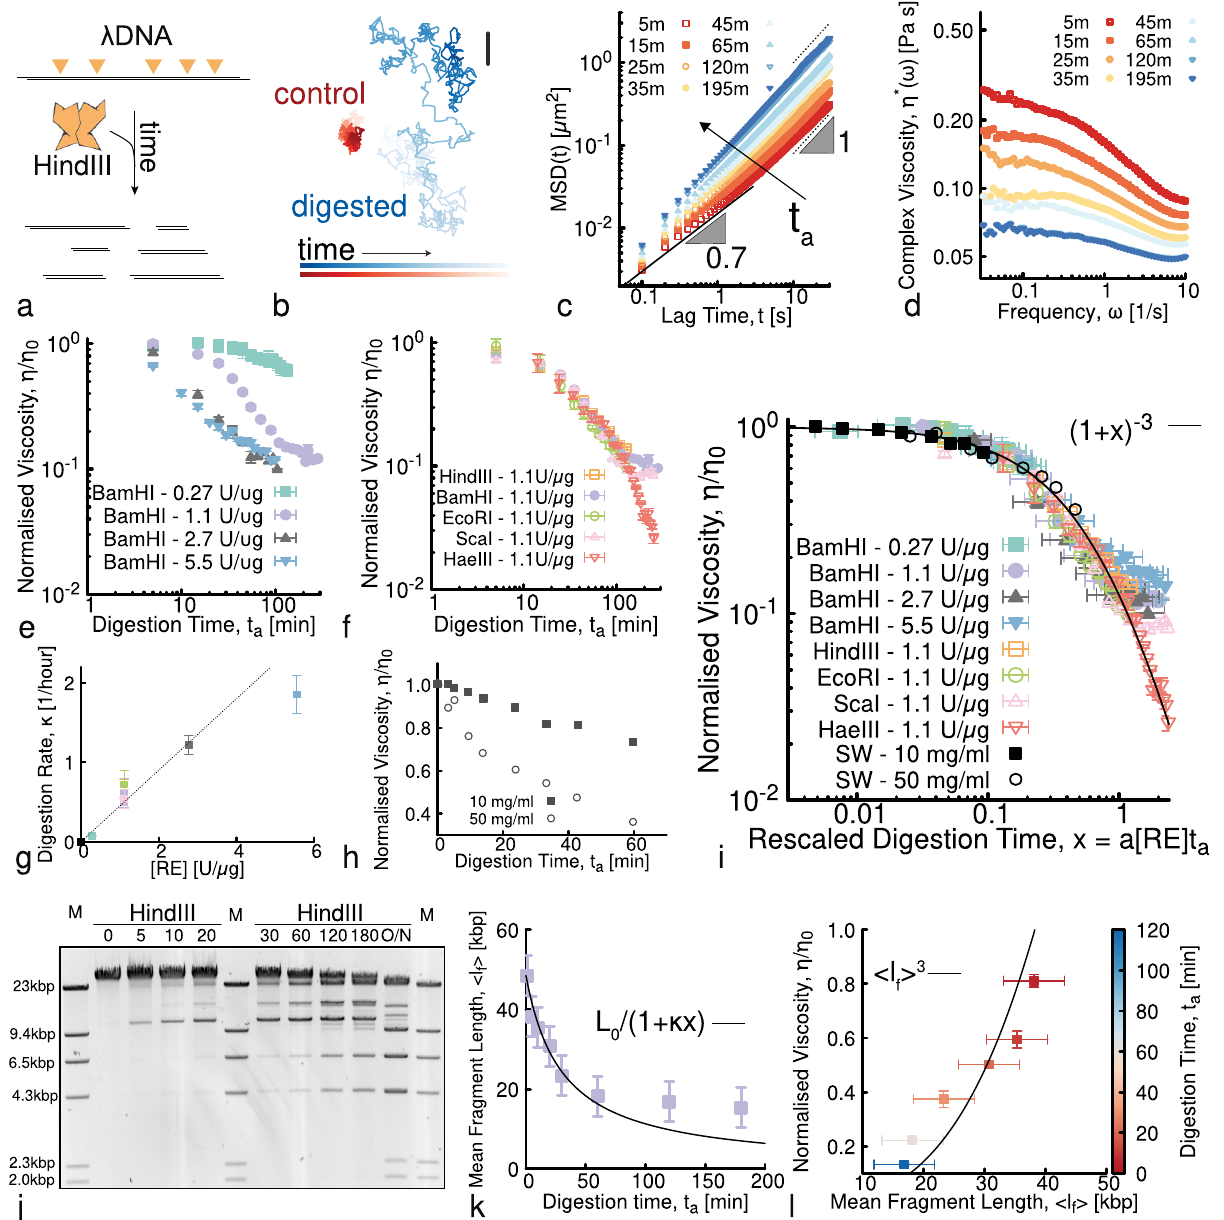
Fig. 4 | Solutions of entangled linear λ -DNA undergoing digestion display a universal decrease in viscosity. a Digestion of linear λ -DNA (48.5kbp) into smaller fragments via a multi-cutter RE HindIII. b Representative trajectories from microrheology in inactive (control, red) and digested (blue) solutions. Shading from dark to light indicates increasing tracking time. Scale bar is 1 μ m. c Mean- squared displacements (MSD) versus lag time t at different digestion times t a (shown in minutes in the legend) after the addition of 1.1U/ μ g of HindIII. Black dotted and solid lines represent power-law scaling MSD~ t α , with corresponding scaling exponents listed. d The complex viscosity η * ( ω ) at different digestion times displays a shear-thinning behaviour that weakens at long digestion times. e , f Viscosity during digestion time as a function of ( e ) different RE (BamHI) concentrations (listed as RE:DNA stoichiometry in the legend) and ( f ) different RE ( fi xed stoichiometry 1.1U/ μ g) (See Supplementary Table 1 for more information on REs). g By fi tting the data shown in e , f with (1+ κ t ) − 3 (see Eq. (2)), we fi nd the